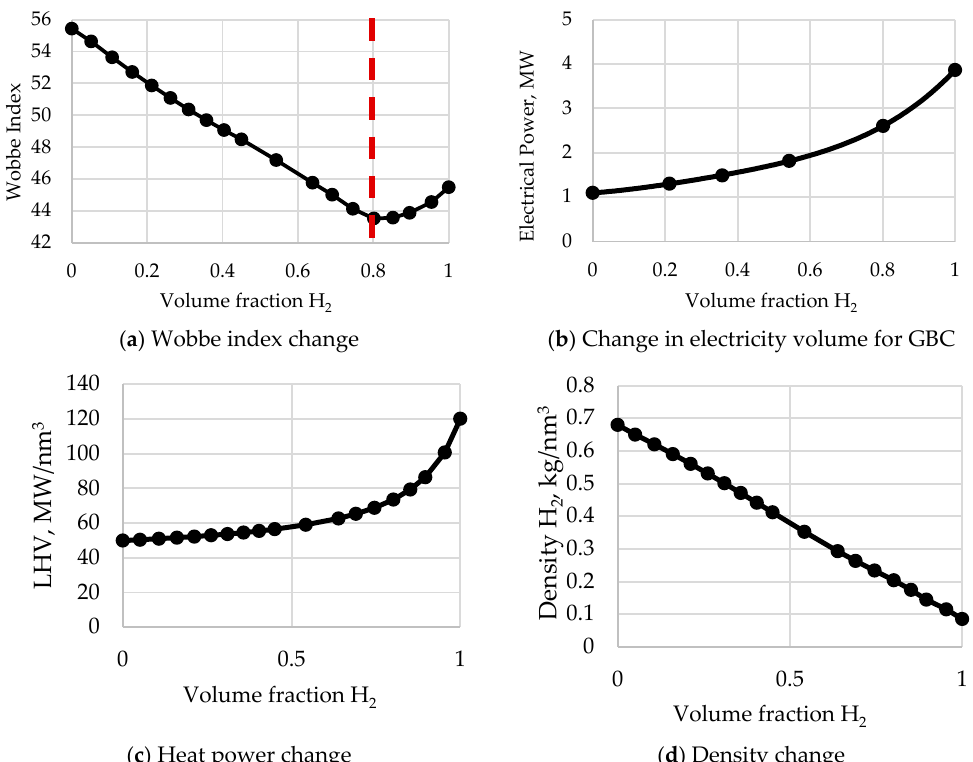
Figure 8. The influence of the volume fraction of hydrogen on the performance of gas turbines. The minimum of the Wobbe index curve is associated with the low density of hydro- gen, due to which with an increase in the volume fraction of hydrogen above 80%, an intense hyperbolic increase in the volumetric thermal power occurs (Figure 9c) and a lin- ear decrease in fuel density (Figure 9b).